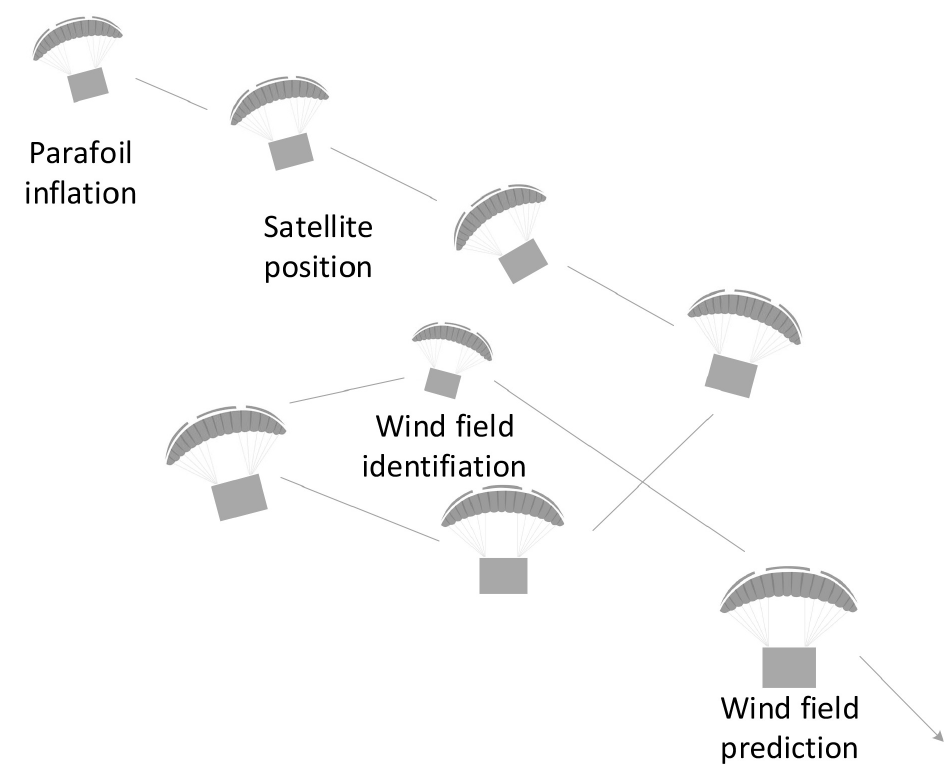
Figure 3. The wind field prediction of parafoil systems.